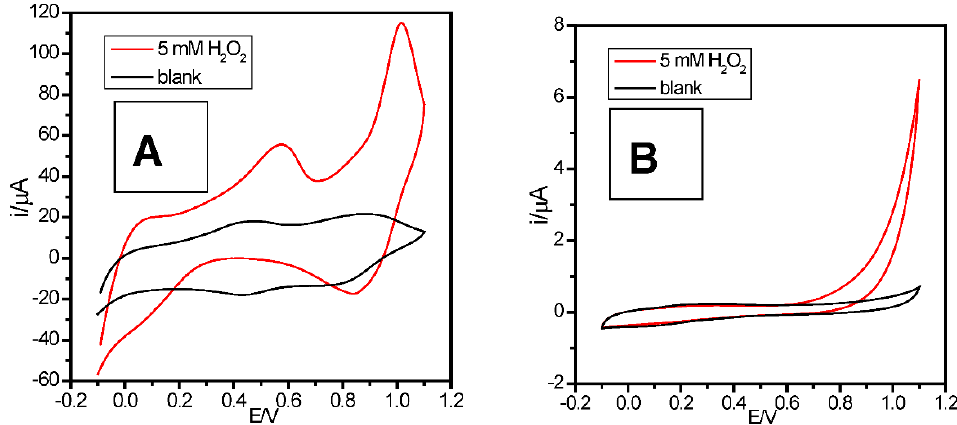
Figure 6. ( A ) Cyclic voltammogram of MnO x ‐ LS in supporting electrolyte (Na 2 SO 4 ) and in the presence 5 mM H 2 O 2 ; ( B ) Cyclic voltammogram of polymerized LS ‐ H in supporting electrolyte (Na 2 SO 4 ) and in the presence 5 mM H 2 O 2 .